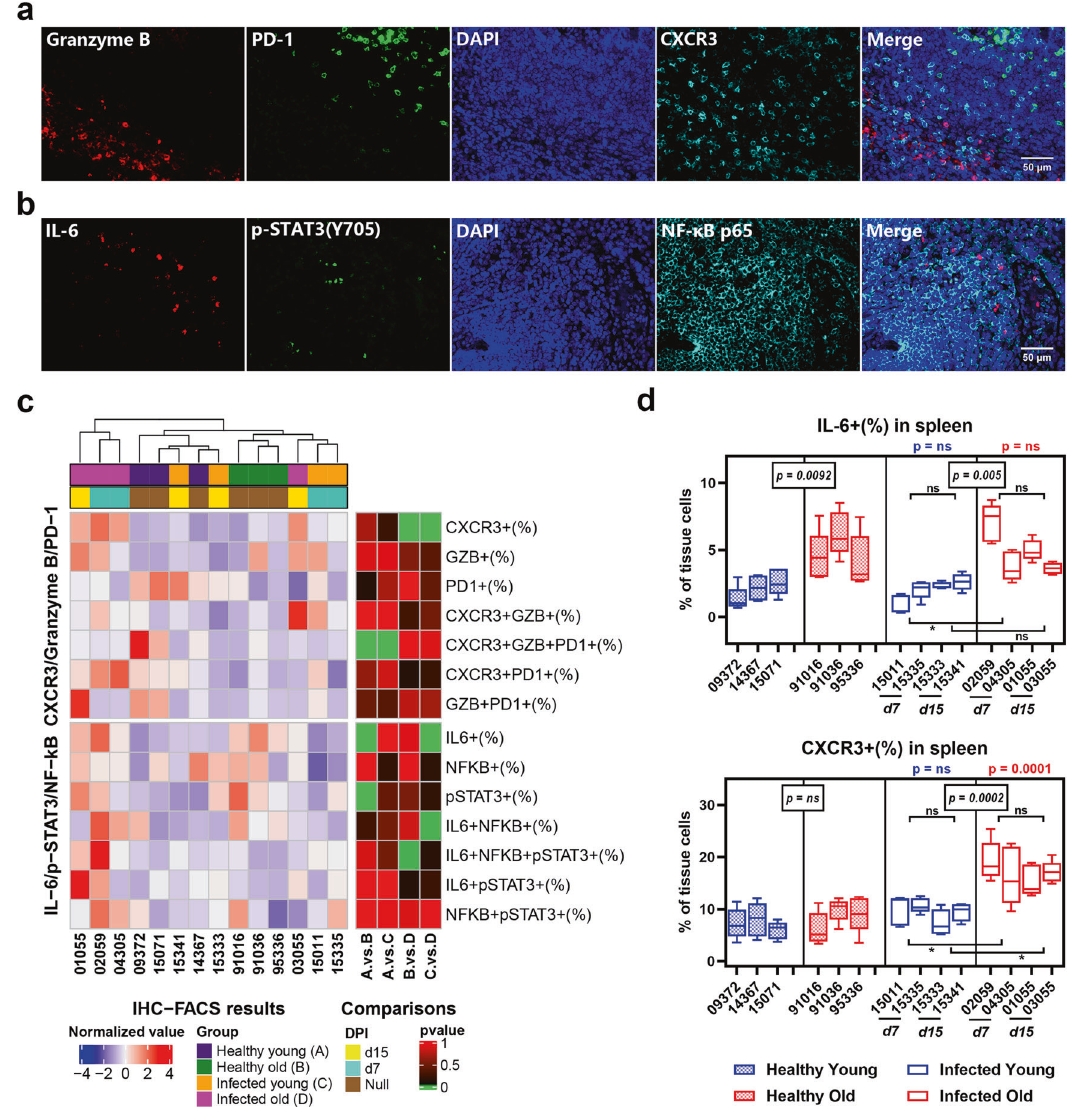
Fig. 5 Accumulation of CXCR3 + cells in spleen tissues of old RMs infected with SARS-CoV-2. a , b mIF images showing the co-staining results of immune markers in spleen tissue sections. Red, green, and cyan indicate staining of protein markers, and blue DAPI staining indicates nucleus. c Staining results according to a and b of each animal are displayed in a heat map. Annotation bar indicates group and DPI of each sample; heat map on left represents the normalized average frequency of each cell subsets by R ’ s scale method, mapped by red-white-blue gradient squares; heat map on right represents p values for comparisons between each group, and square with grass green was considered to be a statistically signi fi cant difference ( p ≤ 0.05). d Box plots showing the frequency of IL-6 + and CXCR3 + cells in spleen tissues in healthy young, healthy old, infected young, and infected old groups. Data calculated using fi ve microscopy images of the spleen tissue section from each animal are shown as median with min to max. P value marked in blue indicates the comparison between infected and healthy young groups, and red indicates the comparison between infected and healthy old groups. Boxed p value represents a comparison between young and old RMs in healthy (left) or infected (right) conditions. Square brackets in the fi gure show a comparison between infected young and old RMs at different time points (7 and 15 DPI). * p ≤ 0.05; ns, p >